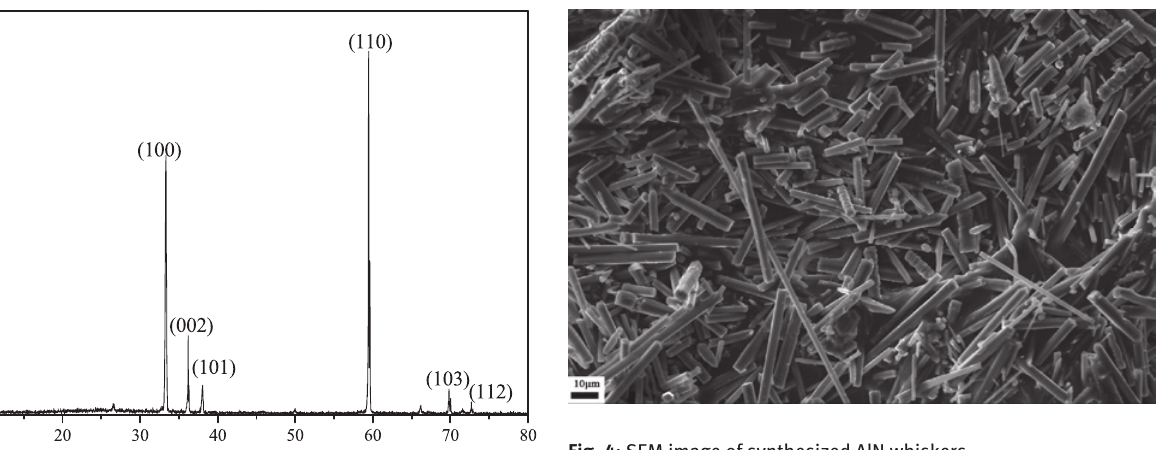
Fig. 4: SEM image of synthesized AlN whiskers